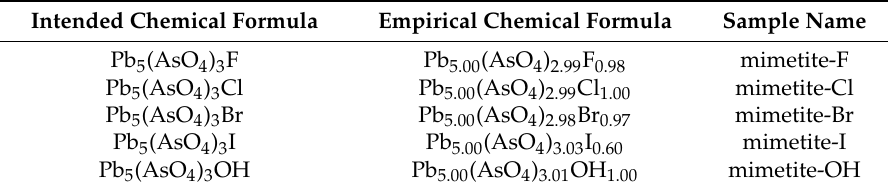
Table 1. Chemical composition of synthetic